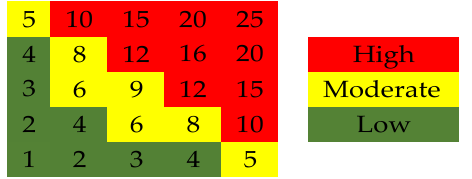
Figure 3. 3 Classes Matrix Matrix. Table 4. Dataset.